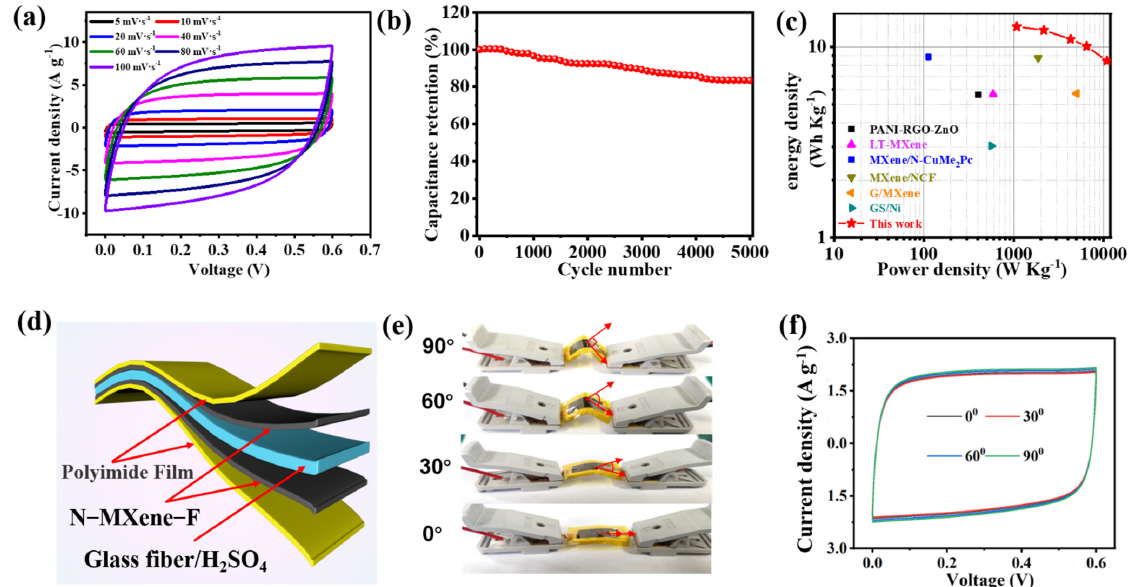
Figure 5. Electrochemical performance of the SSC: ( a ) CV curves at different scan rates; ( b ) specific capacitance retention of SSC at a current density of 10 A g − 1 ; ( c ) Ragone plots displaying energy and power densities of N-MXene-F//N-MXene-F SSC in comparison with other MXene-based and graphene-based supercapacitors; ( d ) SSC assembly schematic; ( e ) digital photos of SSC with different bending angles; ( f ) CV curves of SSC under different bending angles.